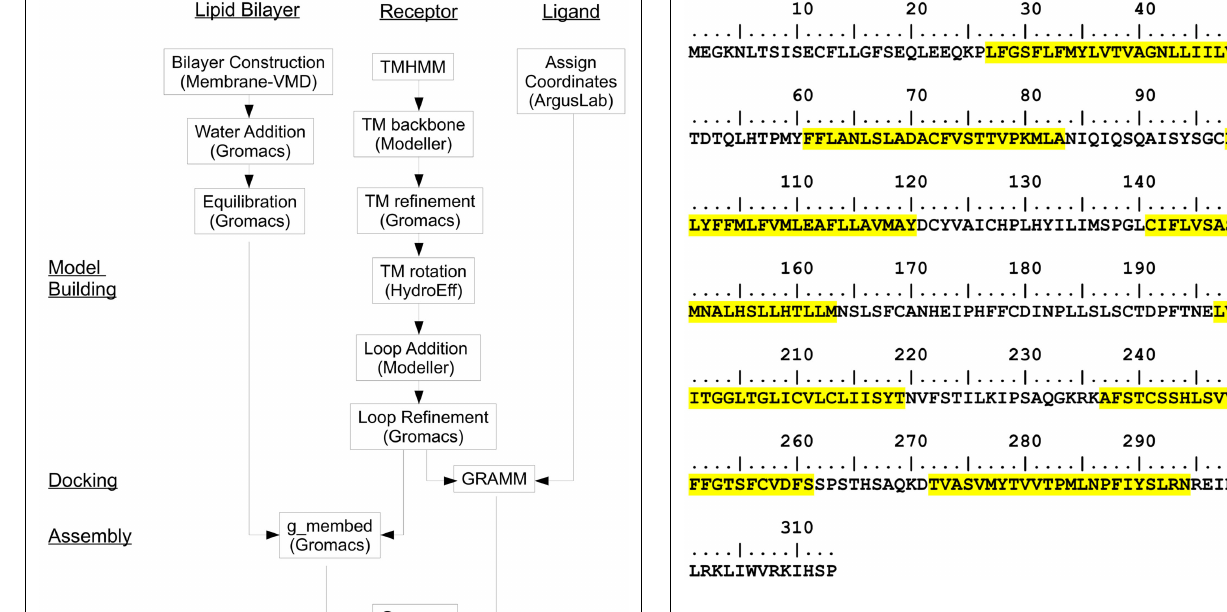
FIGURE 2 | hOR17-209TM prediction results fromTMHMM. Predicted locations and lengths of transmembrane helices are highlighted in yellow. The non-highlighted regions are modeled as free-standing